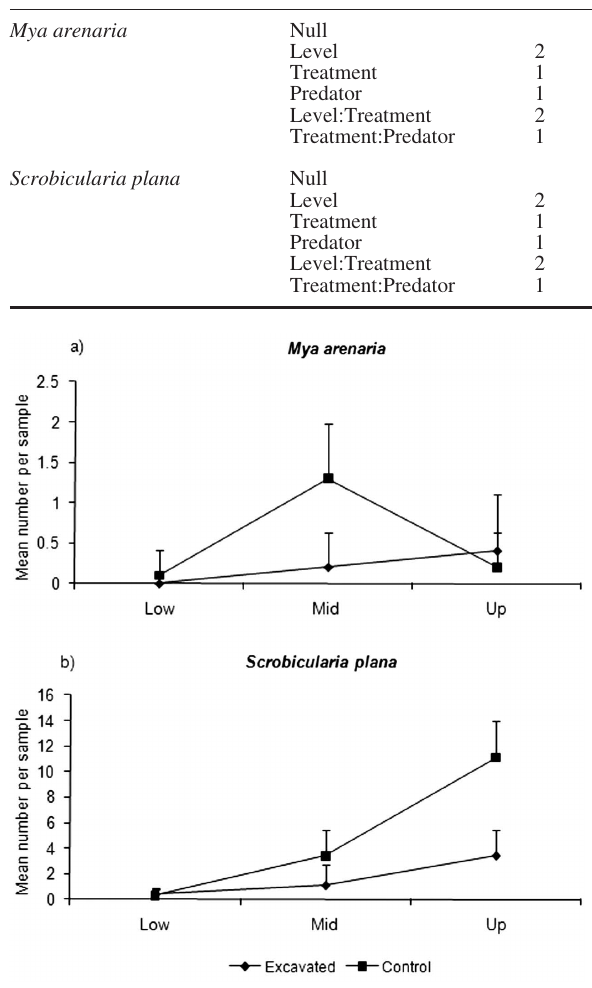
Fig . 5. – Interaction plot for the categorical factors expressed as the mean density per sample (and standard deviation) of the juveniles of Mya arenaria (a) and Scrobicularia plana